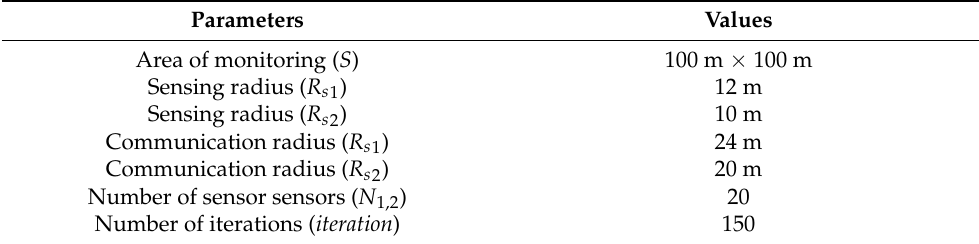
Table 14. Experimental 2 parameter configurations.